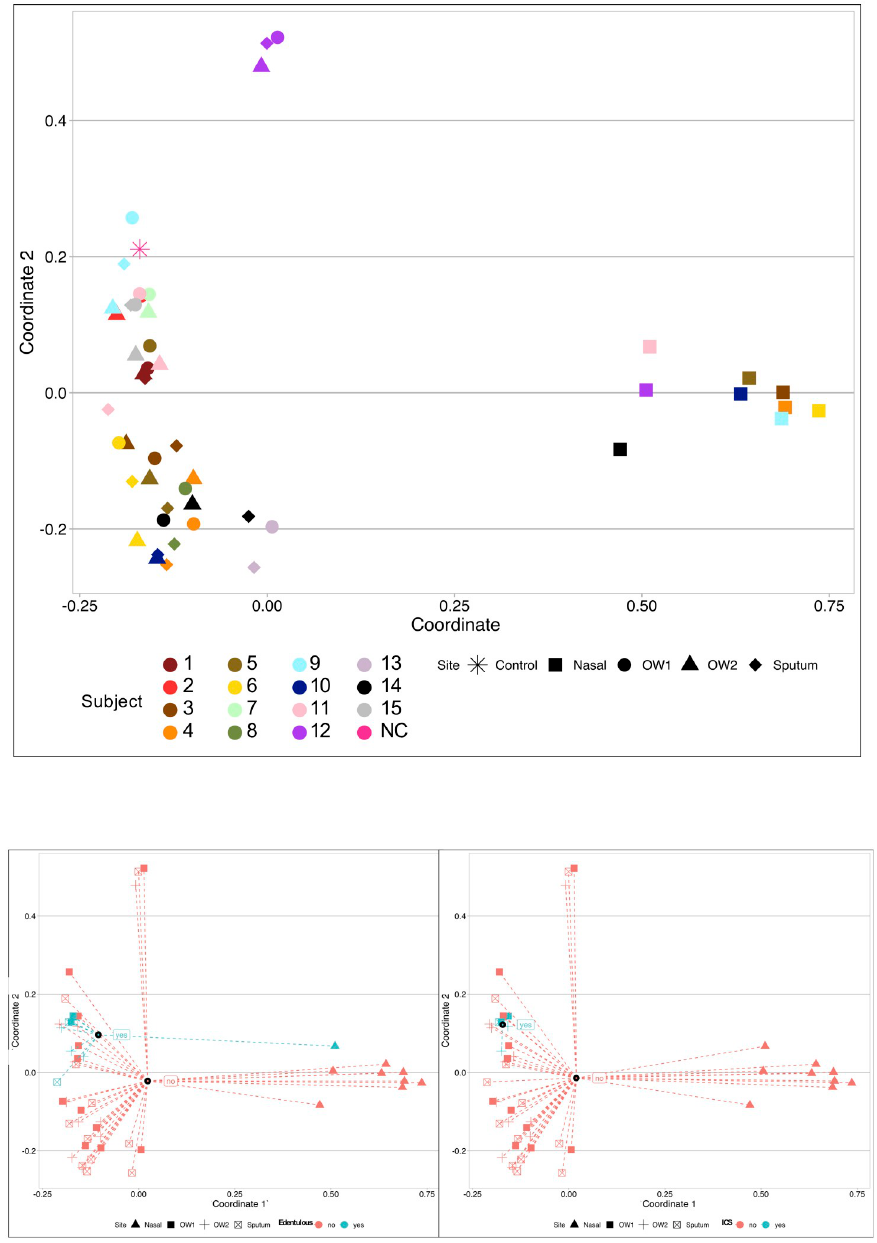
Fig 6. Beta diversity demonstrates clustering by anatomic site, inhaled corticosteroid use, and edentulous state. Principal coordinate analysis (PCoA) using Bray-Curtis dissimilarity followed by PERMANOVA analyses were used to identify clinical factors responsible for sample clustering on β -diversity analyses. Upper panel : Anatomic site is indicated by symbol, while each subject is labeled with a unique color. Anatomic site (nasal vs. sputum vs. oral wash 1 vs. oral wash 2) was again a significant predictor of beta-diversity ( p = 0.001). Oral wash 1 and oral wash 2 samples did not form separate clusters ( p = 0.93); sputum samples also failed to cluster separately from either of the oral wash sample groups ( p = 0.62). This confirms that nasal samples (triangles at right) were responsible for the clustering by anatomic site. Neither FEV1pp ( � 80% vs. < 80%; p = 0.077) nor current tobacco use (current tobacco users or recent quitters vs. remote quitters; p = 0.062) were associated with β -diversity. Notably, the sputum and oral wash samples from subject 12 clustered together at the upper left, separate from the other subjects’ oral washes and sputa (these samples from subject 12 were also outliers on α -diversity analyses, see Fig 4). The nasal sample from this subject clustered with the other subjects’ nasal samples. Lower Left : Anatomic site is indicated by symbol, while color is used to indicate edentulous state. Samples from edentulous subjects clustered separately from dentate subjects ( p = 0.019). Lower Right : Anatomic site is indicated by symbol, while color is used to indicate ICS use. ICS users’ samples clustered separately from non-ICS users’ samples ( p =